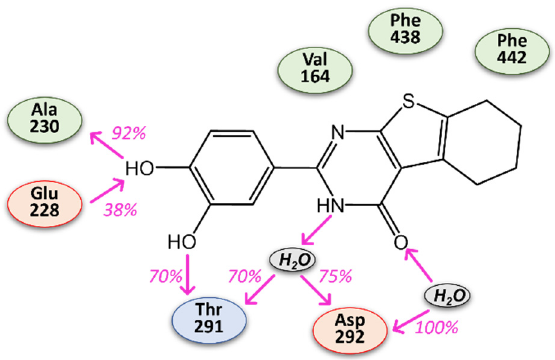
Figure 3. A schematic overview of the MD-derived intermolecular interactions established by T126 within the AKT1 ATP-binding pocket. The key contacts are represented with their occurrence calculated as the average value of the three replicas in the time window 100 − 200 ns. The protein residues are color-coded as follows: red, charged (negative); green, hydrophobic; cyan, polar.